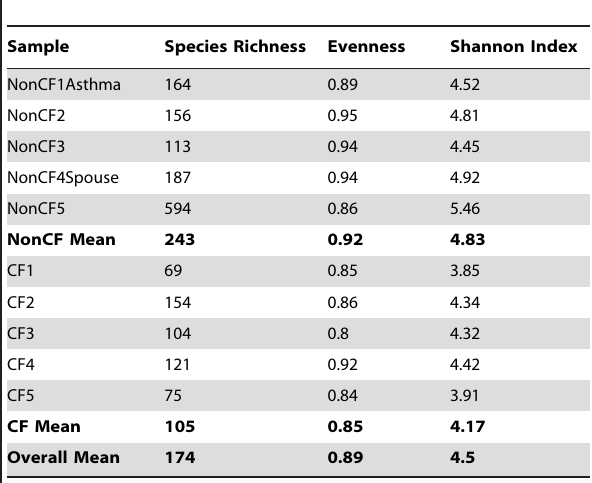
Table 1. Diversity estimates for human respiratory tract DNA